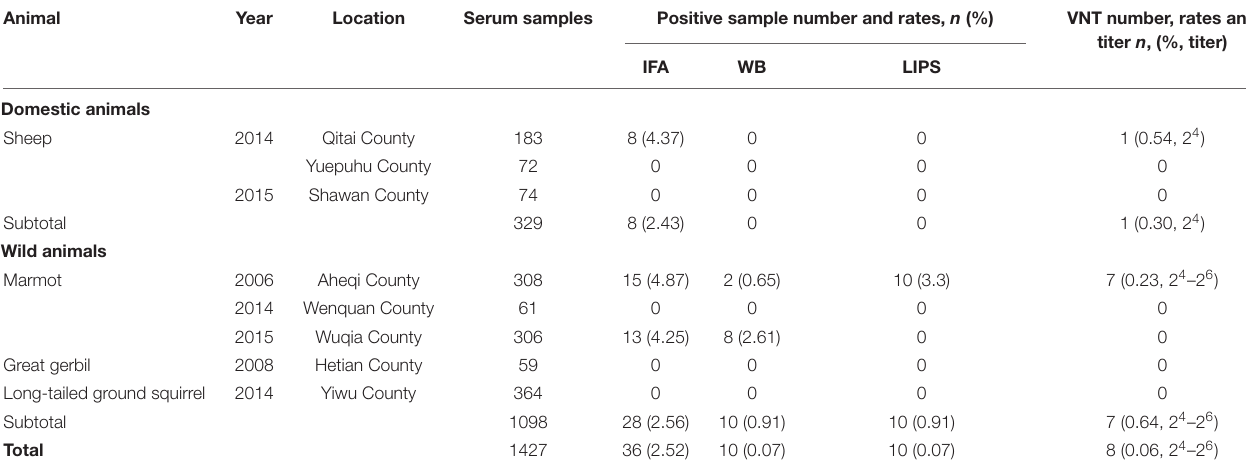
TABLE 2 | Seroprevalence of antibodies to KSIV among domestic and wild animals in Xinjiang. Animal Year Location Serum samples Positive sample number and rates, n (%) VNT number, rates and